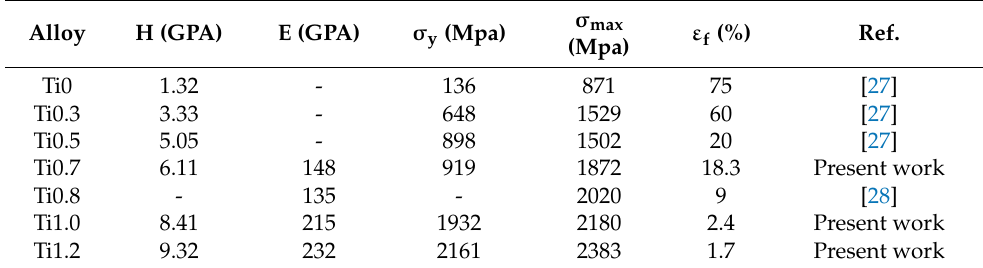
Figure 4. Compressive engineering stress–strain curves for the CoCrFeNiTix alloys. The curves are presented after removing the machine compliance effect. Table 2. Mechanical properties of CoCrFeNiTi x alloys.